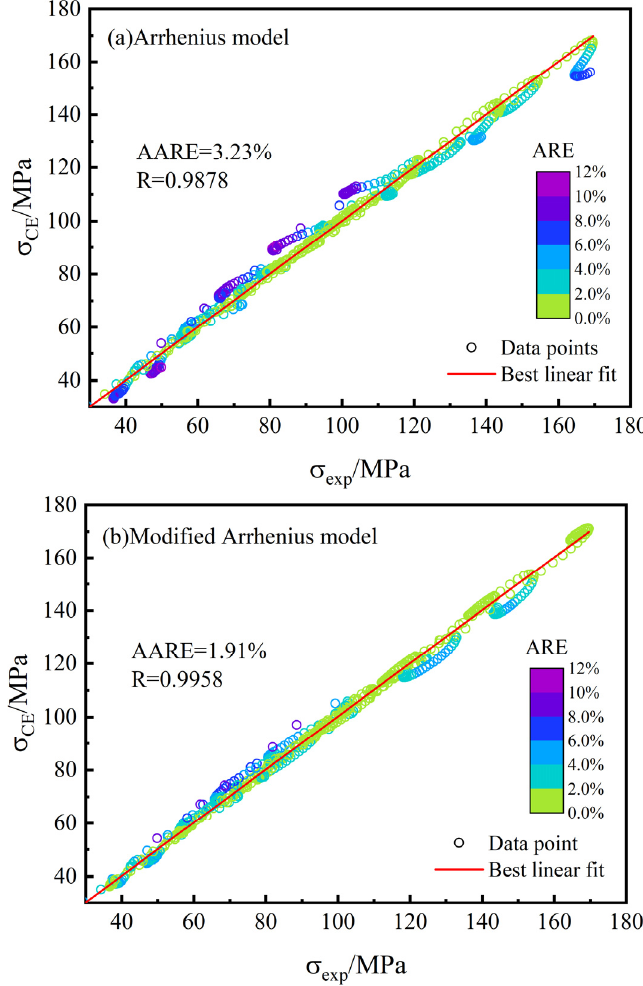
Figure 13. Correlation maps for constitutive models ( a ) Arrhenius model; ( b ) Modified Arrhenius Figure model.